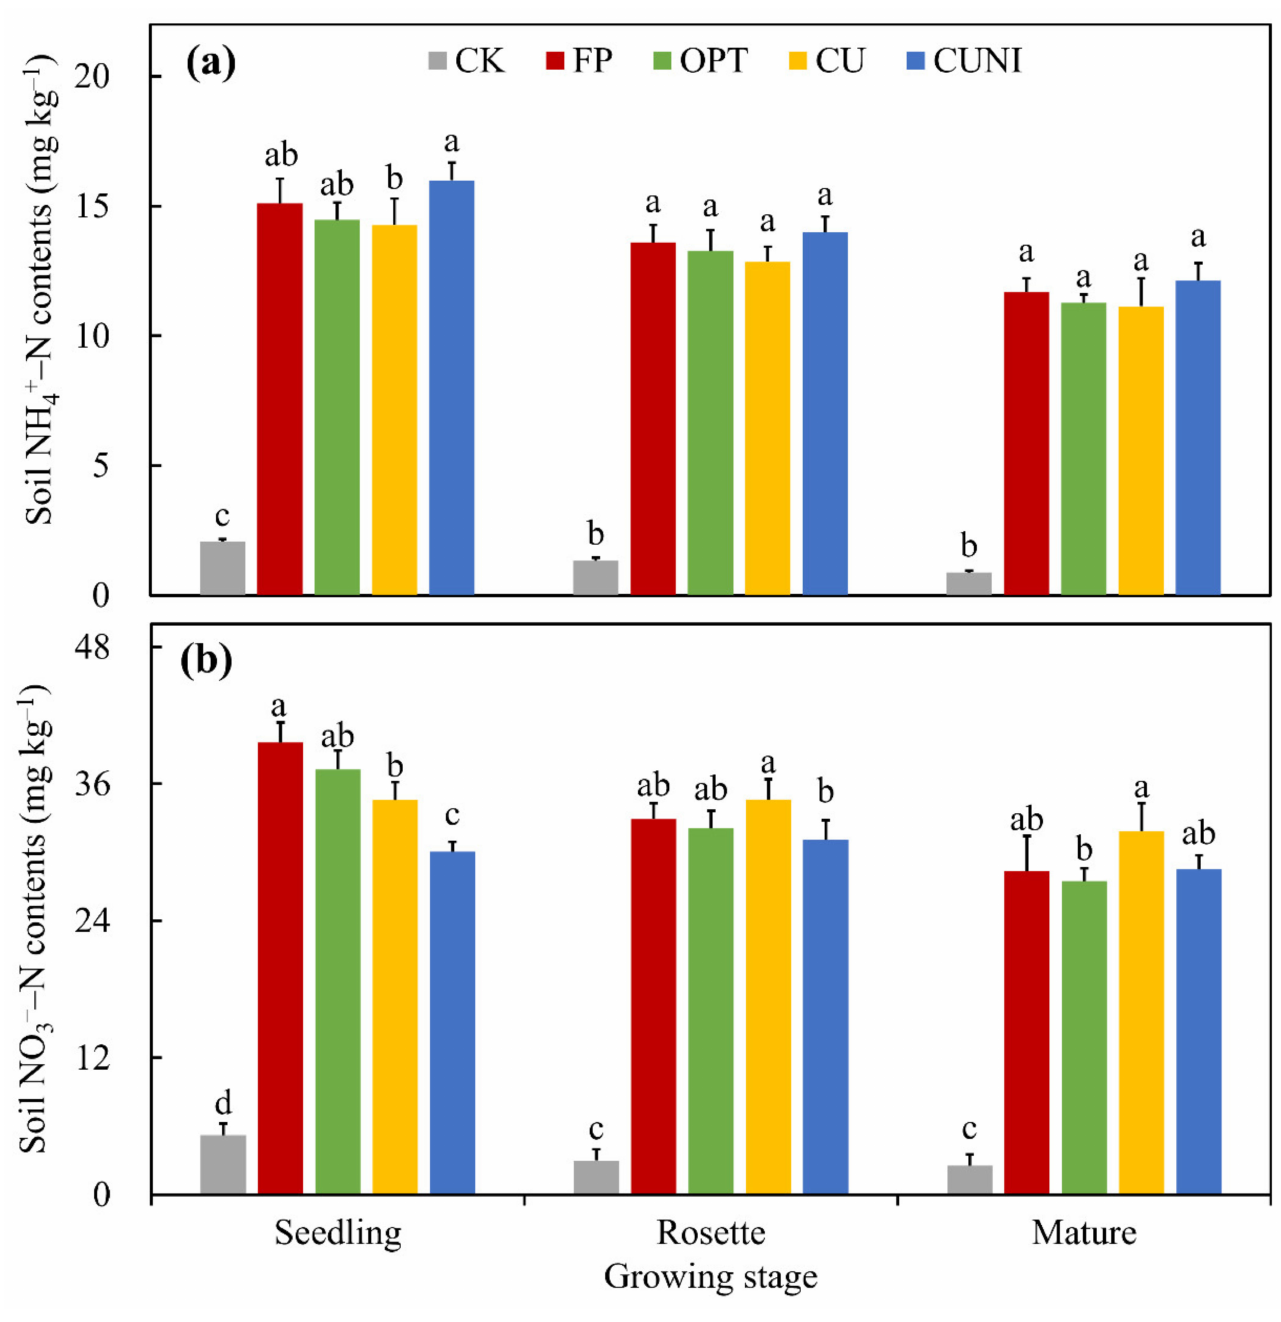
Figure 2. Average soil NH 4+ –N ( a ) and NO 3 − –N ( b ) contents during lettuce growing seasons in 2017–2020. CK, no N fertilizer; FP, conventional urea based on local farmers’ practices; OPT, conven- tional urea at reduced N rate; CU, polyurethane-coated urea at reduced N rate; CUNI, polyurethane- coated urea at reduced N rate in combination with NI. Same letter indicates no significant differences at the level of 0.05. Bars represent standard deviations ( n =